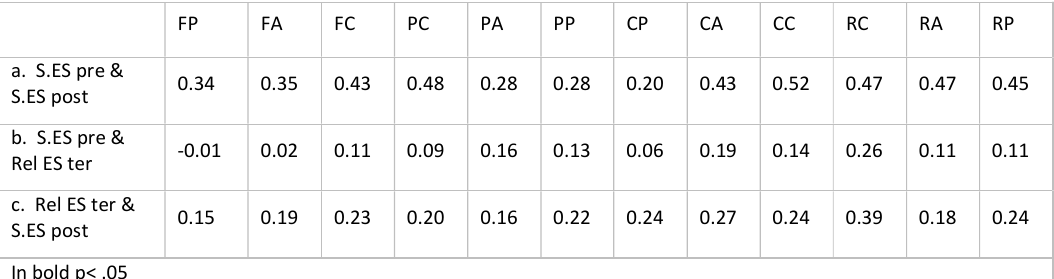
Table 4: Values of r of the diagonals of three matrices of correlation (between corresponding Ego States): a) between pre-treatment and post-treatment 12 Self ES of client; b) between pre-treatment 12 Self ES of client, and 12 Relational ES of therapist focused on client in treatment; c) between 12 Relational ES of therapist focused on client in treatment, and post-treatment 12 Self ES of client (significant p< .05 in